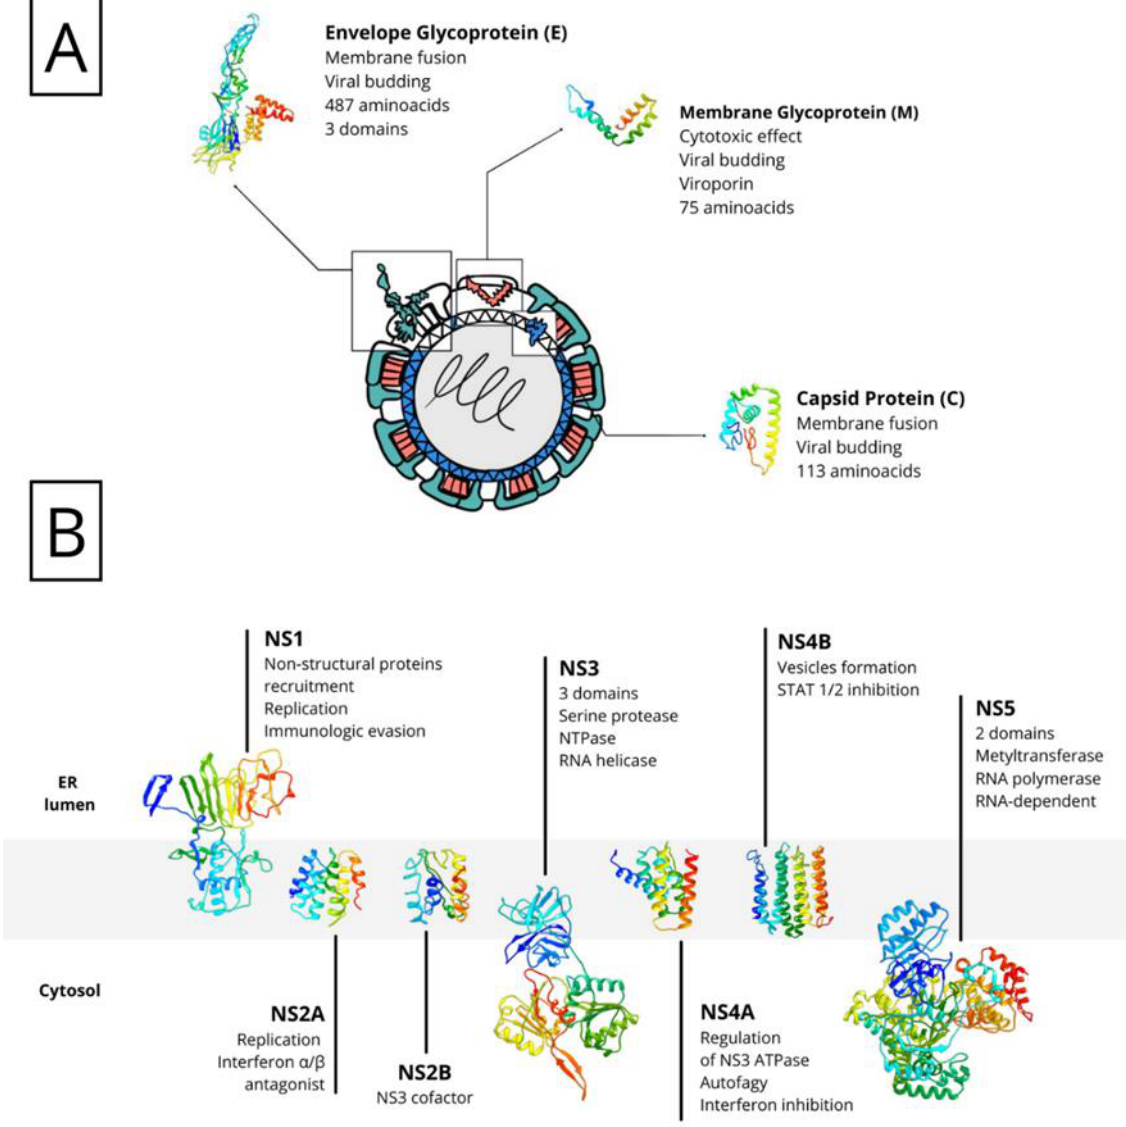
Figure 1. Schematic representation of ROCV proteins. The genome polyprotein is cleaved after translation into two types of proteins: structural proteins ( A ), present in the viral particle and responsible for viral assembly, evasion, and invasion; and non-structural proteins ( B ), present mainly in the endoplasmic reticulum (ER) and needed for the production of new virions.